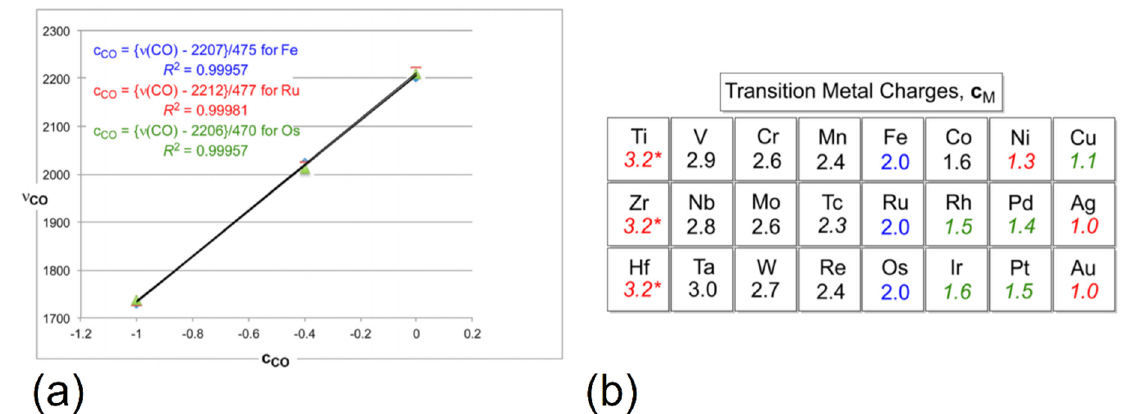
Figure 3. ( a ) Reported average CO stretch frequencies ν for different Fe (blue), Ru (red), and Os (green) carbonyl complexes plotted against their average CO ligand charge c, computed based on a TM charge of +2. ( b ) Average CDVR charges of d block elements relative to the postulated Fe 2+ reference. Charges obtained from limited datasets are given in green italics, those from a single data point in red italics, and the values for the group 4 elements Ti, Zr, and Hf are derived from the respective row trends. Adapted with permission from Ref. [27]. Copyright 2017 American Chemical Society.